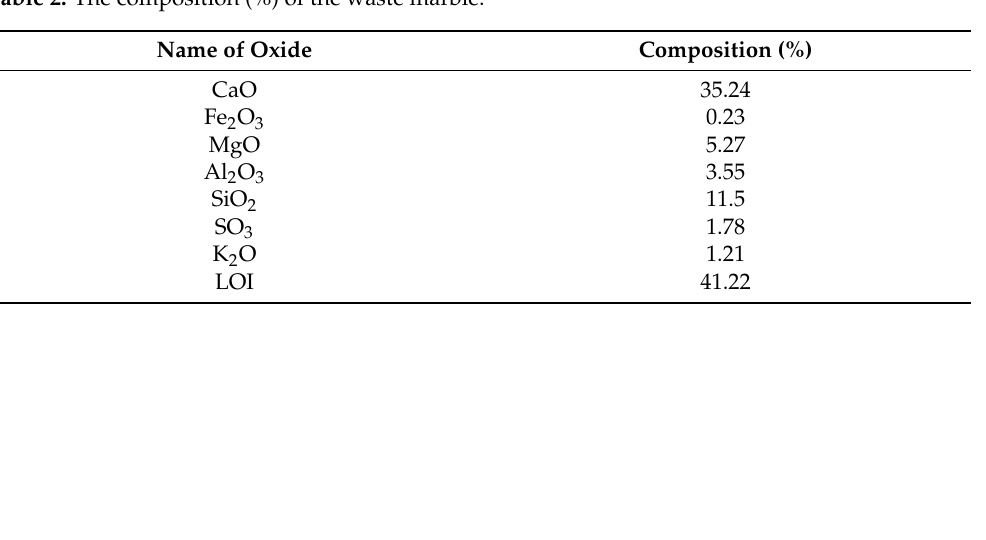
Table 2. The composition (%) of the waste